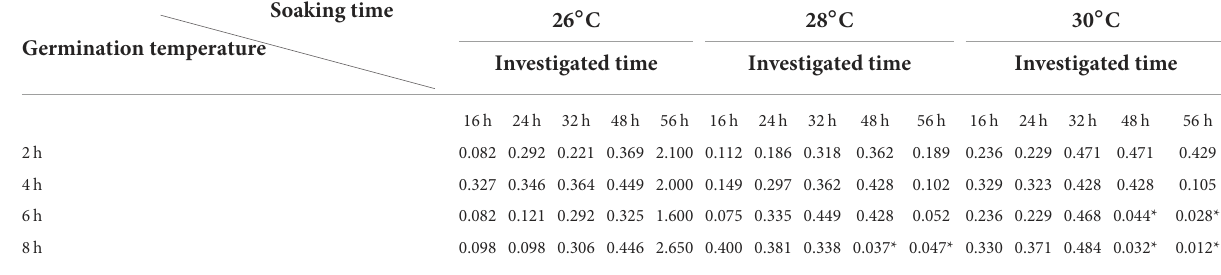
TABLE 2 Significant difference analysis of seed germination rate between parental lines.